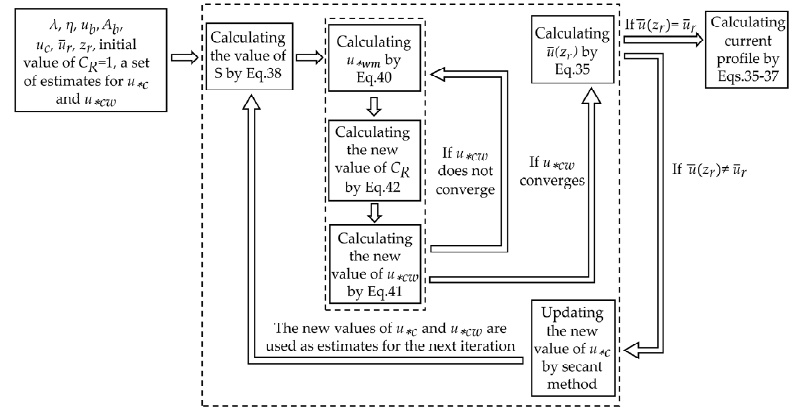
Figure 3. Diagram of the solution procedure.